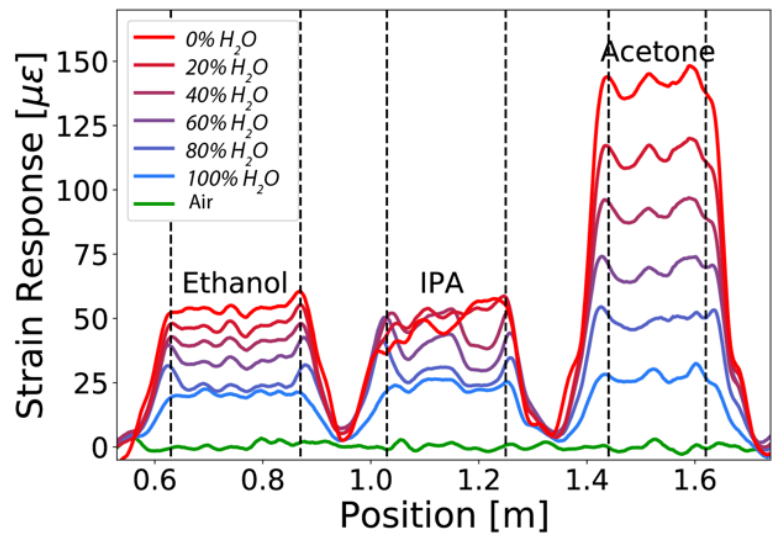
Figure 3. Distributed swelling strain response measured in three different baths containing ethanol, isopropyl alcohol (IPA), and acetone. The volume percent of the water content is varied as indicated in the legend. The dashed vertical lines indicate the boundaries of the segments of the fiber which are fully immersed.